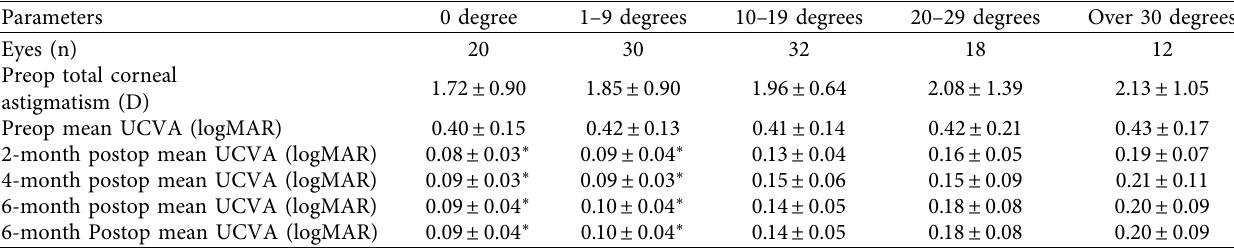
Table 3: Preoperative and postoperative total corneal astigmatism ( D ) and uncorrected visual acuity (UCVA) according to the steep meridian deviation.